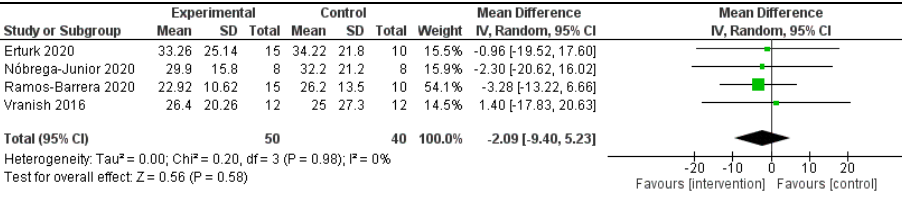
Figure 4. Forest plot for apnoea/hypopnea index.